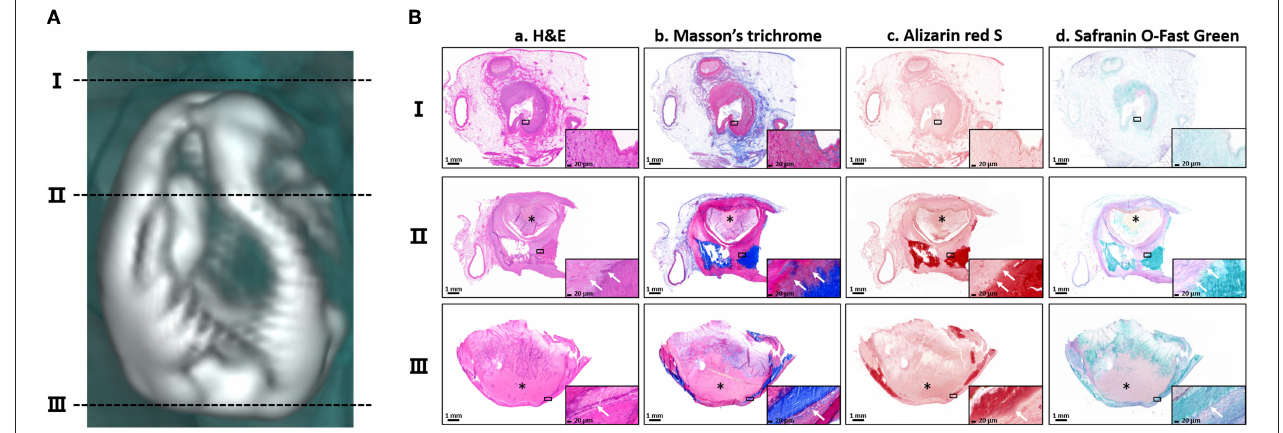
FIGURE 2 | Histopathological features of the calcifications. (A) The three black dotted-lines indicate the positions of the selected horizontal sections of the calcification located in the left atrium. The corresponding numbers are shown on the left. (B) Staining of the three horizontal sections with (a) hematoxylin–eosin (H&E), (b) Masson’s trichrome, (c) Alizarin red and (d) Safranin O-fast green. Magnified images are shown in the lower corner of each image. The asterisks indicate the thrombus. The white arrows indicate the pathological infiltration of calcium salts. Scale bars are shown at the bottom of each image.